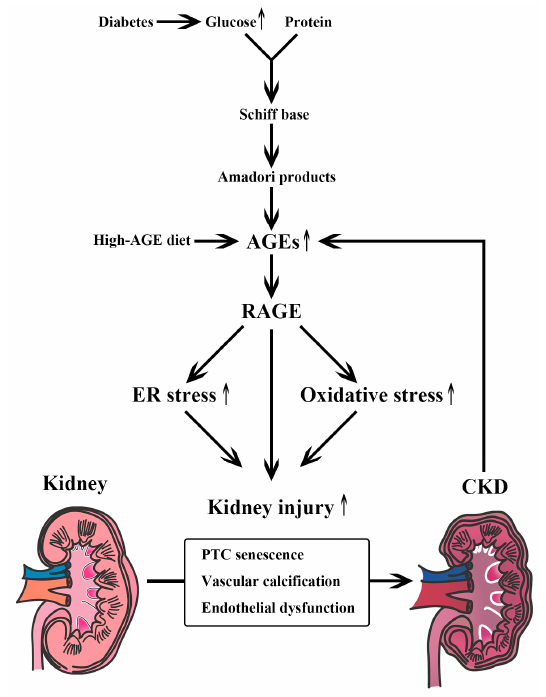
Figure 1. Glycative stress and chronic kidney disease (CKD). Glycative stress caused by uremic toxins, such as AGEs, derived from glycation is closely associated with CKD progression through the activation of the AGE-RAGE system. AGEs; Advanced glycated end products, RAGE; the receptor for AGEs, PTC; proximal tubular epithelial cells.